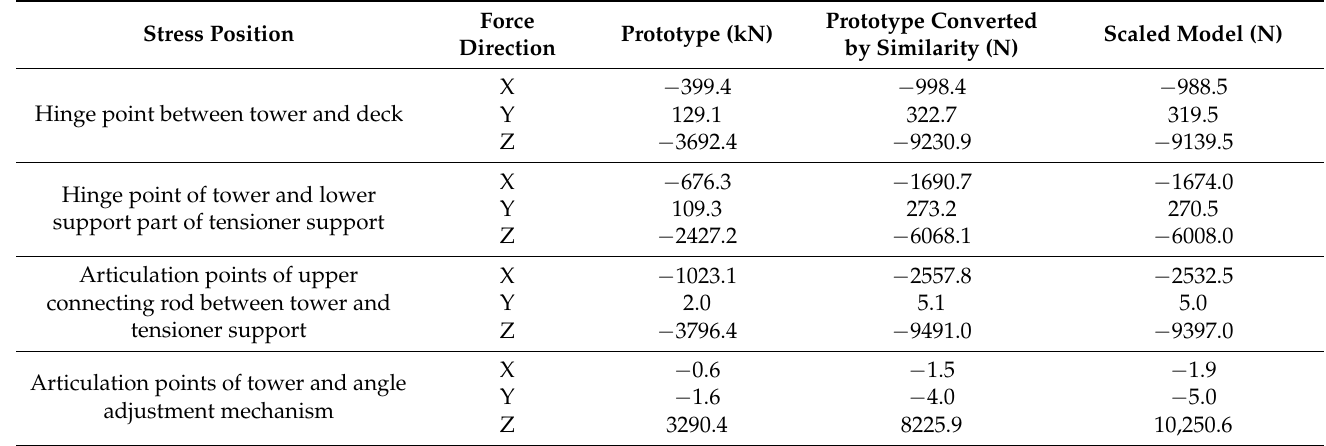
Table A6. Maximum force during angle